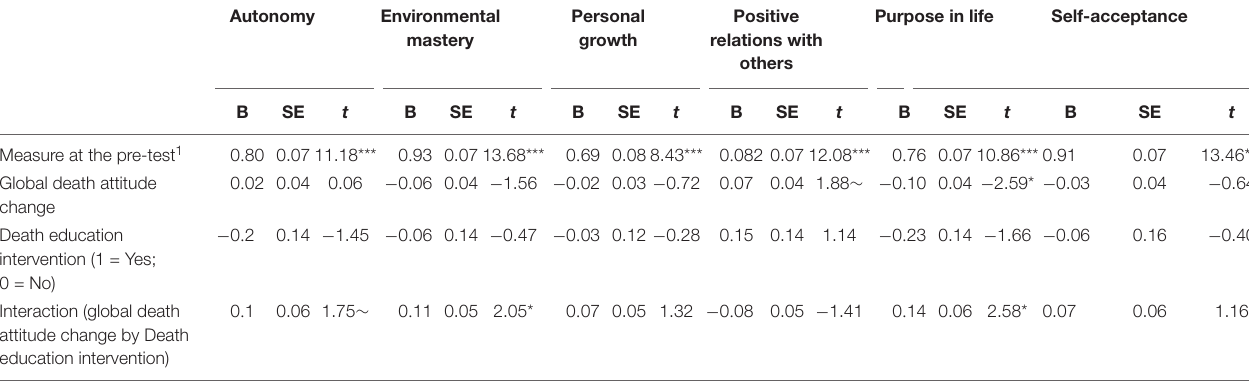
Autonomy Environmental